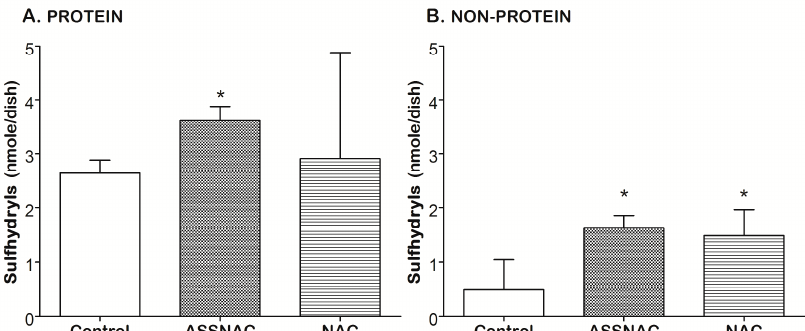
Figure 4. Effect of ASSNAC and NAC on free sulfhydryls level in ARPE-19 cells. Confluent ARPE-19 cells were incubated without (control) or with ASSNAC (0.2 mM) or NAC (2.0 mM) for 24 h. Cells were labeled with mBBr, washed, lysed, and the protein free sulfhydryls ( A ) and non-protein free sulfhydryls ( B ) were determined. ASSNAC and NAC significantly increased total and non-protein sulfhydryls, while only ASSNAC significantly increased protein sulfhydryls (* p ≤ 0.05). 3.2. ASSNAC Protects ARPE-19 Cells from Oxidation-Induced Cytotoxic Effect Survival of ARPE-19 cells pre-treated without or with ASSNAC (0.2 mM; 24 h) and further exposed to 0.05 mM t -BuOOH (24 h) was 53% and 83%, to 0.1 mM t -BuOOH (24 h) was 6% and 57% (Figure 5A); to 0.3 mM H 2 O 2 (1 h) was 32% and 53% (Figure 5B); to 7.5 mM homocysteine was 77% and 98% and to 10 mM homocysteine (24 h) was 20% and 47% (Figure 5C), respectively. ASSNAC treatment alone did not affect cell survival. These results demonstrate the significant protective effect of ASSNAC against various oxidants induced cell death.